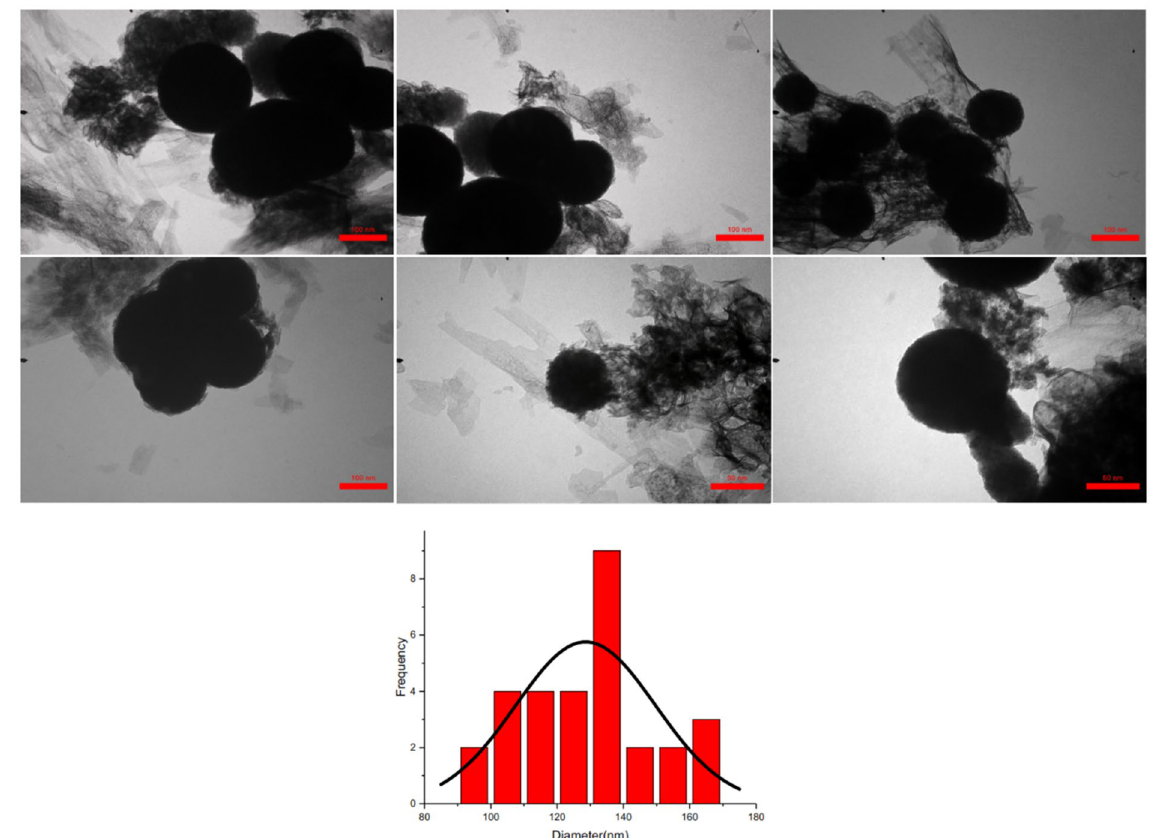
Figure 7. TEM images and particle size distribution histogram of Zn-MOF